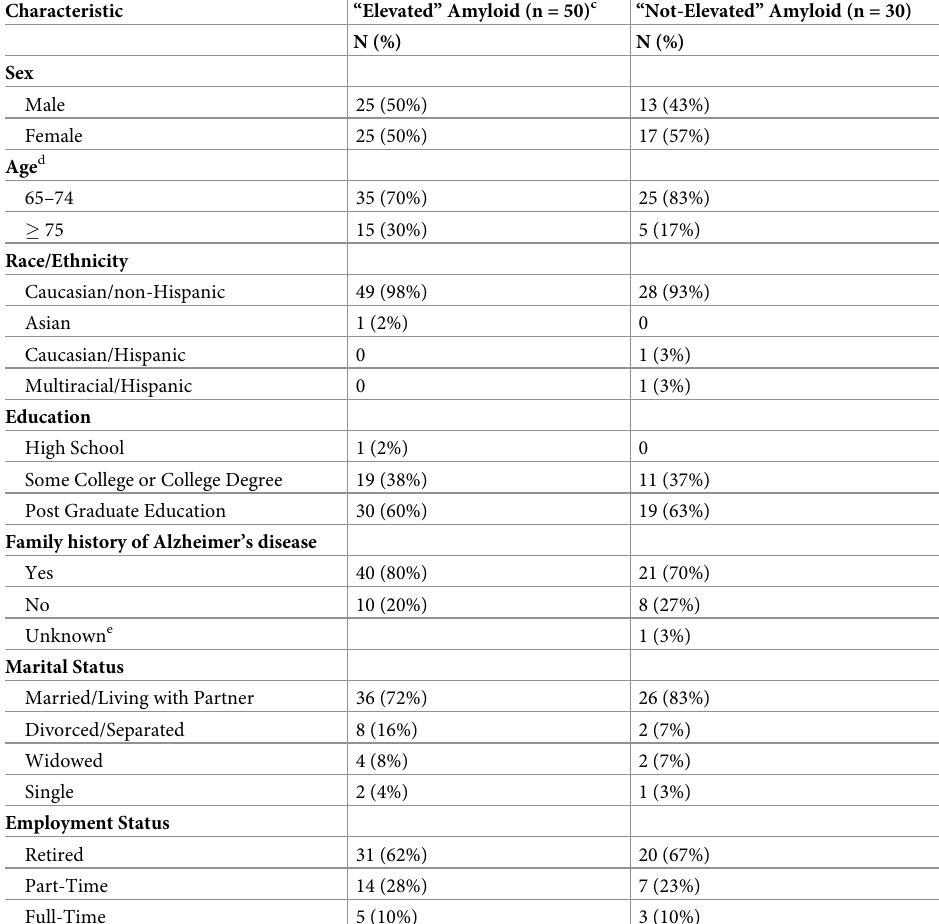
Table 1. Demographic characteristics of SOKRATES subjects by amyloid status at time of the initial interview a,b . Characteristic “Elevated” Amyloid (n = 50) c “Not-Elevated” Amyloid (n = 30) N (%) N (%) Sex Male 25 (50%) 13 (43%) 25